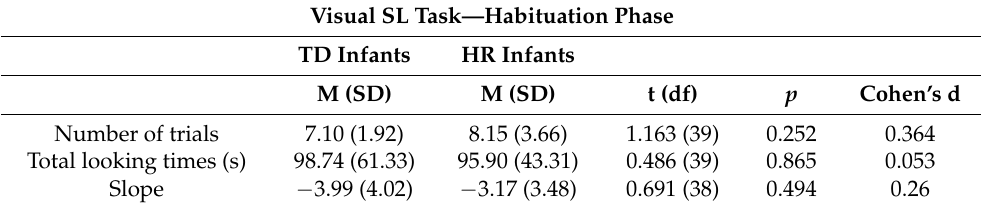
Table 2. Descriptive statistics of the habituation variables (i.e., number of trials, total looking times, and slope of looking times to habituate) for both the TD and HR infants; independent-samples t -tests were used to compare habituation performance between the two groups. Visual SL Task—Habituation